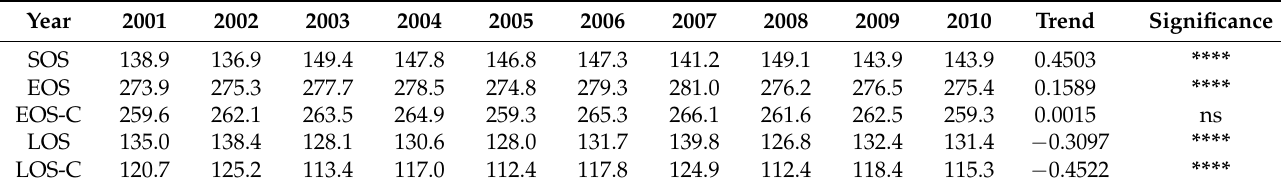
Table 4. Annual mean values of and temporal trends (day year − 1 ) at the start (SOS), end (EOS), and length of the cropland growing season (LOS) in Northeast China from 2001 to 2010. The trend is evaluated as the linear slope term fitted to the growing season time series at the pixel scale. Trend